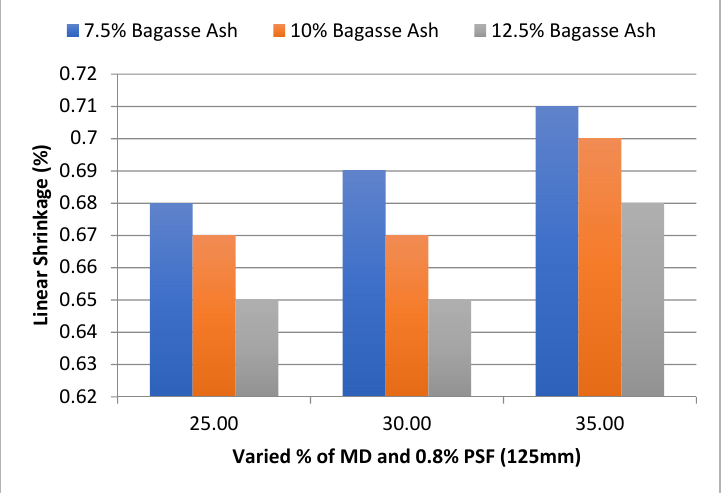
Figure 17. Effect of MD and BA on linear shrinkage of block reinforced with 0.8% PS fiber (125 mm). In addition, the effect of MD and BA on the linear shrinkage of adobe block admixed with 1% and 1.2% paddy straw fiber of length 125 mm was studied, as shown in Figures 18 and 19. It was found that linear shrinkage showed an increment with an increase in marble dust to 30% marble dust and then a gradual decrease towards 35% marble dust at constant bagasse ash content.